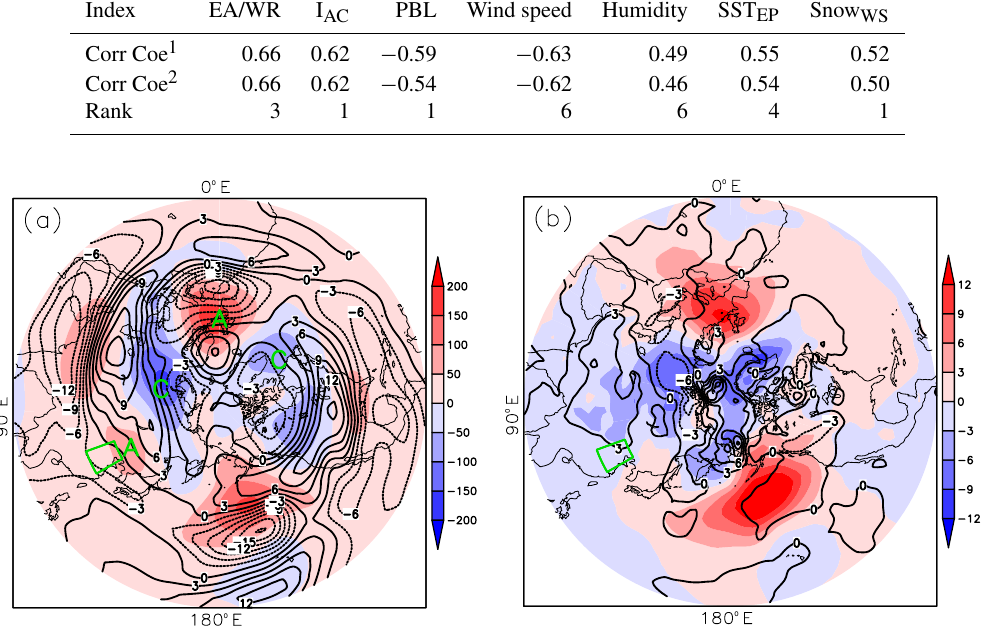
Figure 2. Distribution of the global atmospheric circulation anomalies, (a) Z500 (shading) and U200 (contour) and (b) SLP (shading) and SAT (contour) in December 2016. The anomalies here are calculated with respect to the period from 1981 to 2010.